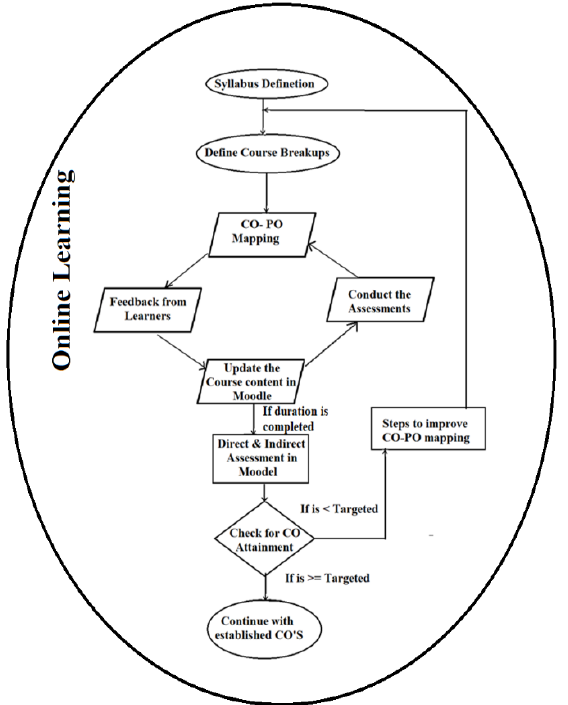
Figure 6. Learners adopted Online T-L Process with CO-PO attainment in